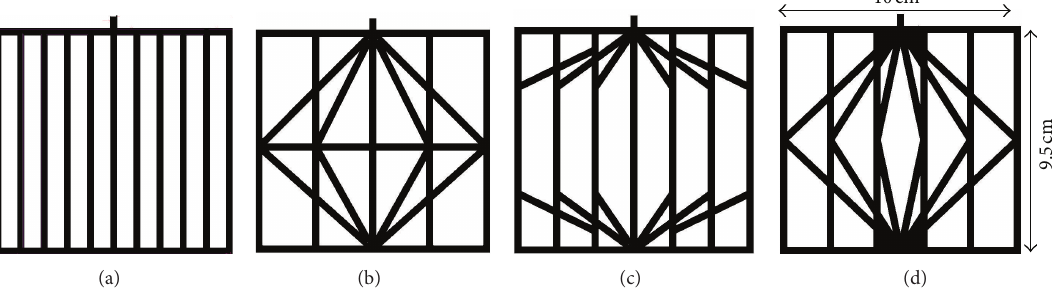
Figure 10: Geometries of collector electrodes used for actual experiments. (a) Standard geometry for experiments (Standard 󸀠 ), (b) Geometry 2 󸀠 , (c) Geometry 3 󸀠 , and (d) Geometry 4 󸀠 .